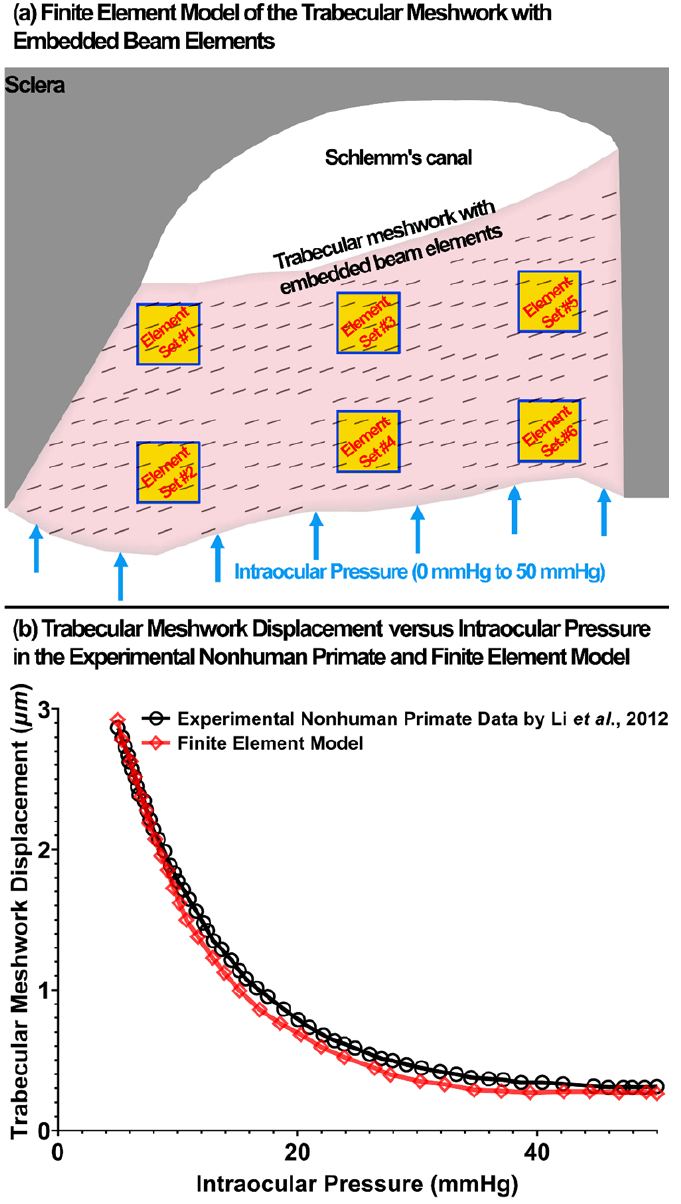
Figure 9. ( a ) The finite element model of the TM with embedded beam elements. Six different element sets were defined in the model and the model was subjected to IOP elevation. ( b ) TM displacement versus the IOP in the experimental nonhuman primate [53] and finite element model. The β for the TM, JCT, SC inner wall, and the beam elements in the TM and JCT were assumed to be constant and equal to 109 1/s and 450 1/s for the ECM and beam ele- ments, respectively (Table 2). The initial estimations were then changed to G 0 = 24.98 MPa, G ∞ = 18.81 MPa, and β = 109 1/s for the ECM of the TM, JCT, and SC inner wall (Tables 1 and 2). In the beam elements, the initial estimations were G 0 = 35.2 MPa, G ∞ = 20.51 MPa, and β = 450 1/s (Tables 1 and 2). The upper and lower parameter boundaries for the ECM/beam elements were chosen as 0.10 < G 0 < 100 MPa and 0.10 < G ∞ < 100 MPa. The model was run with the cost function of mean squared er- ror between the SC inner wall nodal coordinates of the HR-OCT experimental data and optimization data. The optimized viscoelastic properties for the TM, JCT, and SC inner wall, and beam elements are reported in Tables 3 and